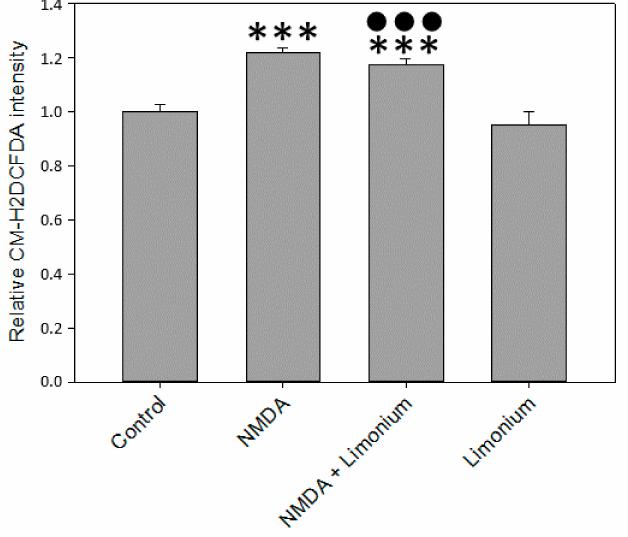
Figure 2. L. gmelinii extract inhibits ROS in human primary neurons exposed to NMDA. The level of ROS is represented by the relative intensity of CM-H2DCFDA normalized to the control group.